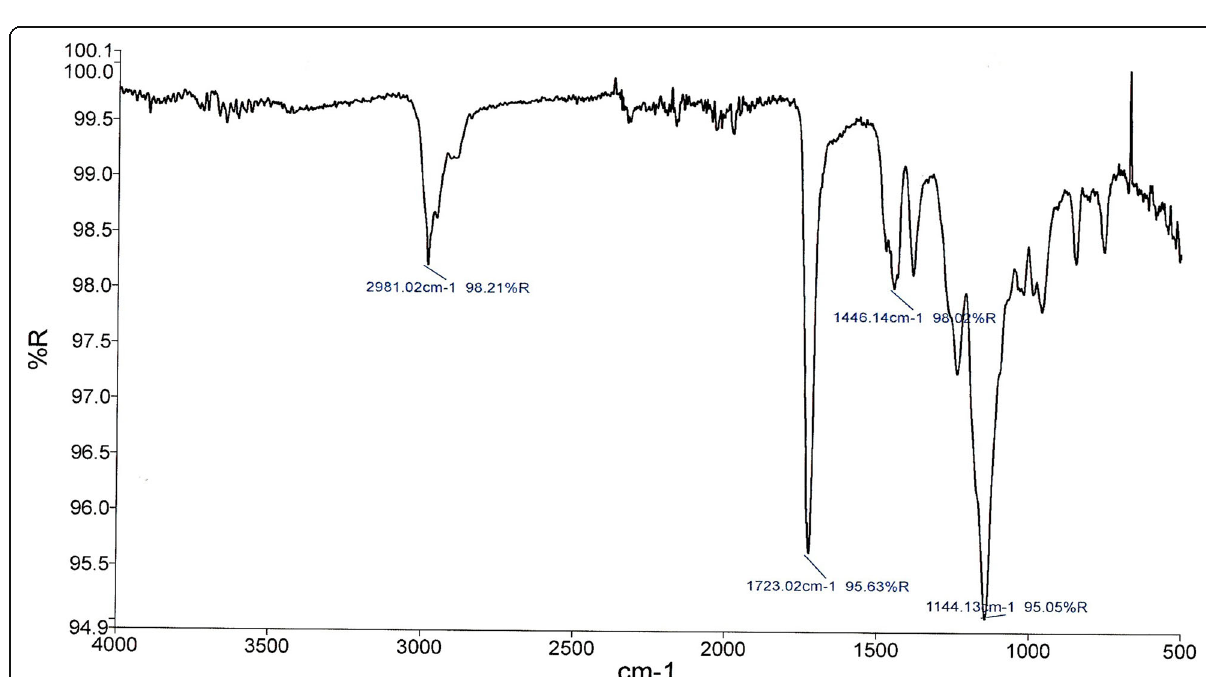
Fig. 4 FTIR spectra of Eudragit